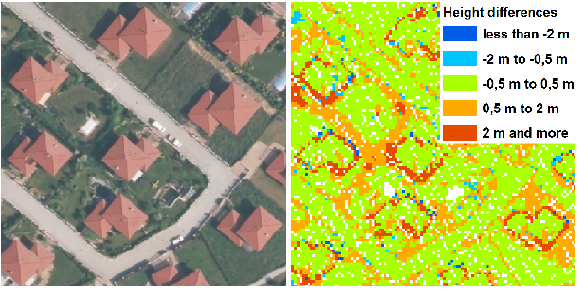
Figure 5. Comparison of ALS and IM point clouds (raster form) 2.1.3 Normalization of